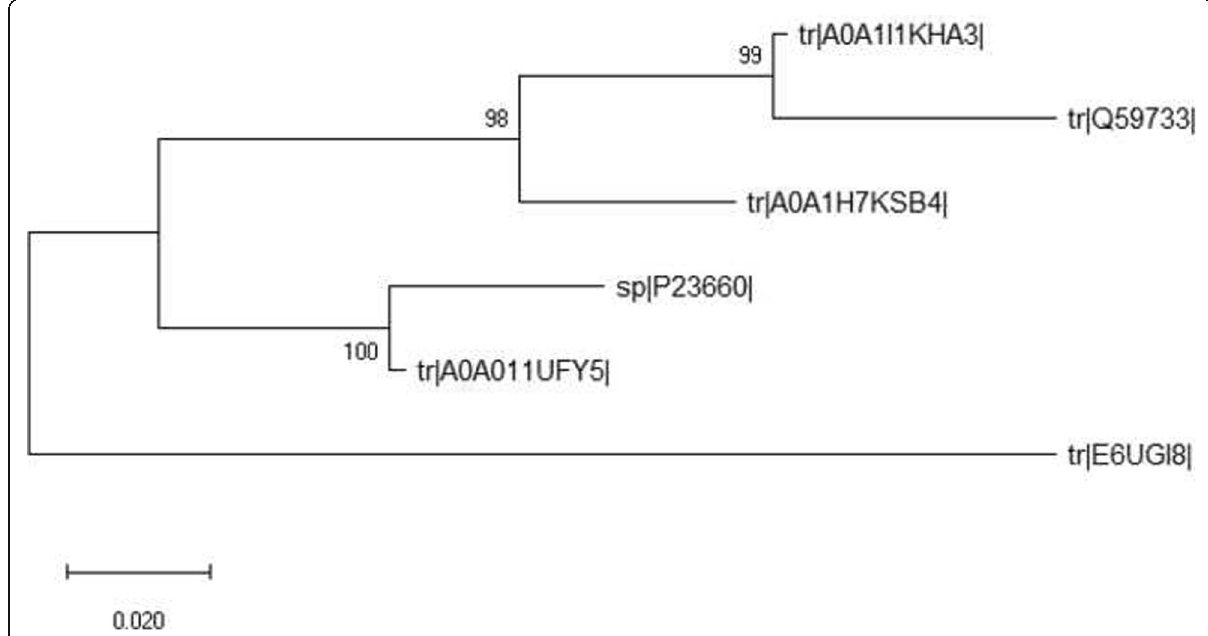
Fig. 1 Phylogenetic tree generated via Mega X software through maximum likelihood method based on JTT matrix-based model, showing the evolutionary relationship among cellulase sequences from different Ruminococcus albus strains. The bootstrap consensus tree is inferred from 1000 replicates, with the confidence values shown next to the